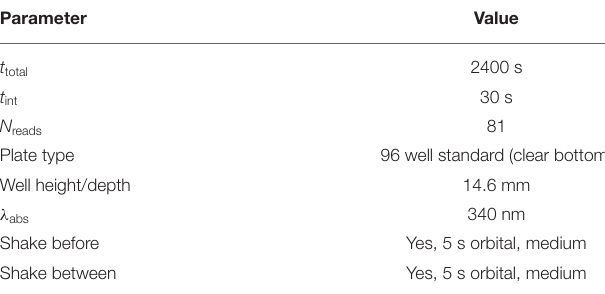
TABLE 2 | Full details of the settings used in our tubulin turbidity measurement protocol based on absorbance